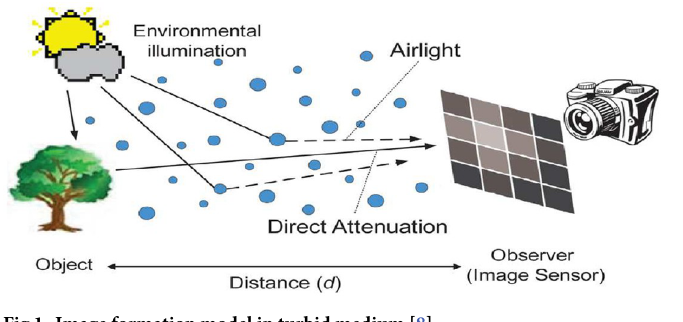
Fig 1. Image formation model in turbid medium